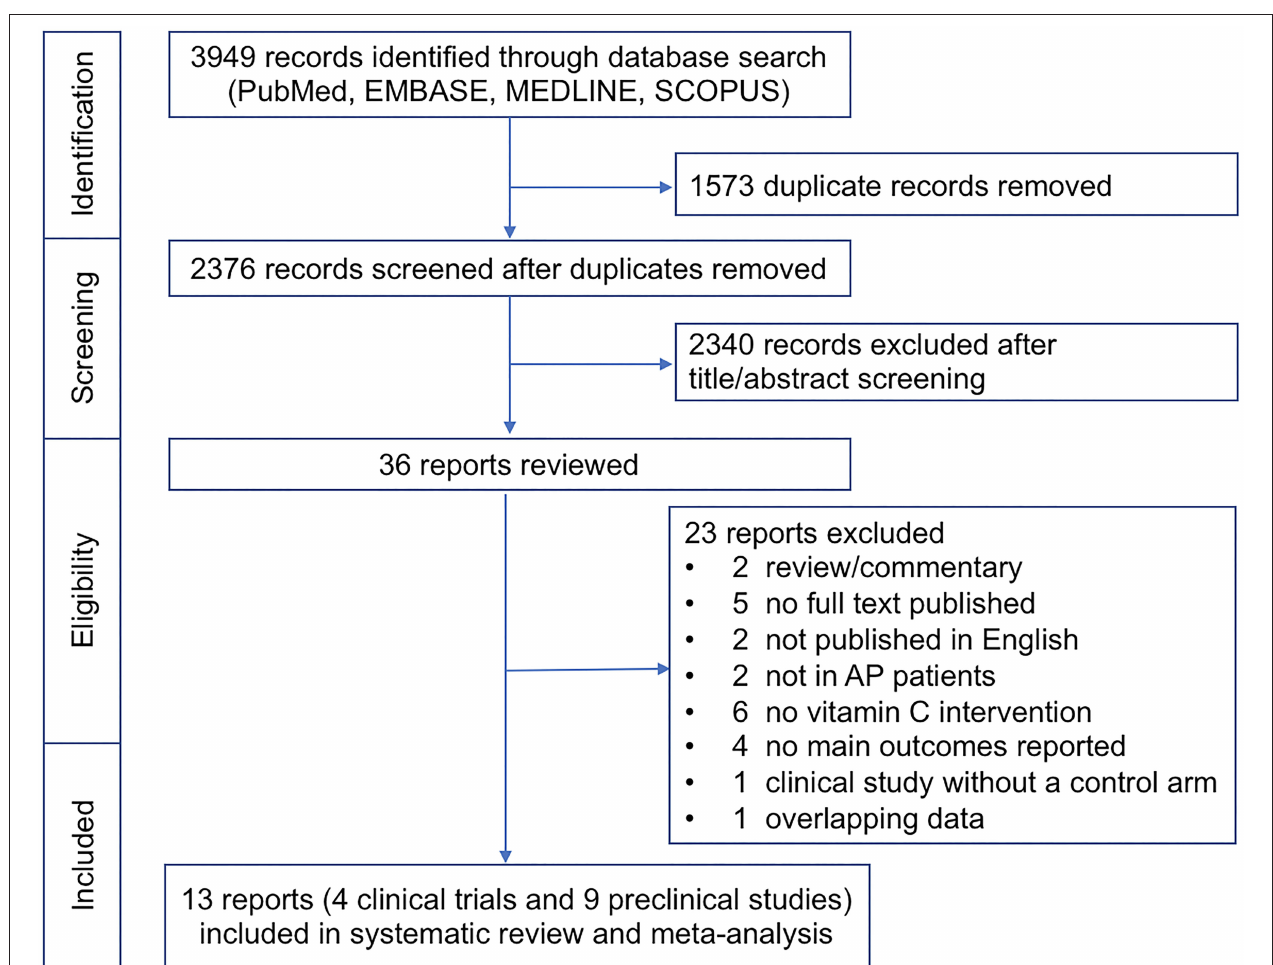
FIGURE 1 | Flow diagram that summarizes the results of the literature